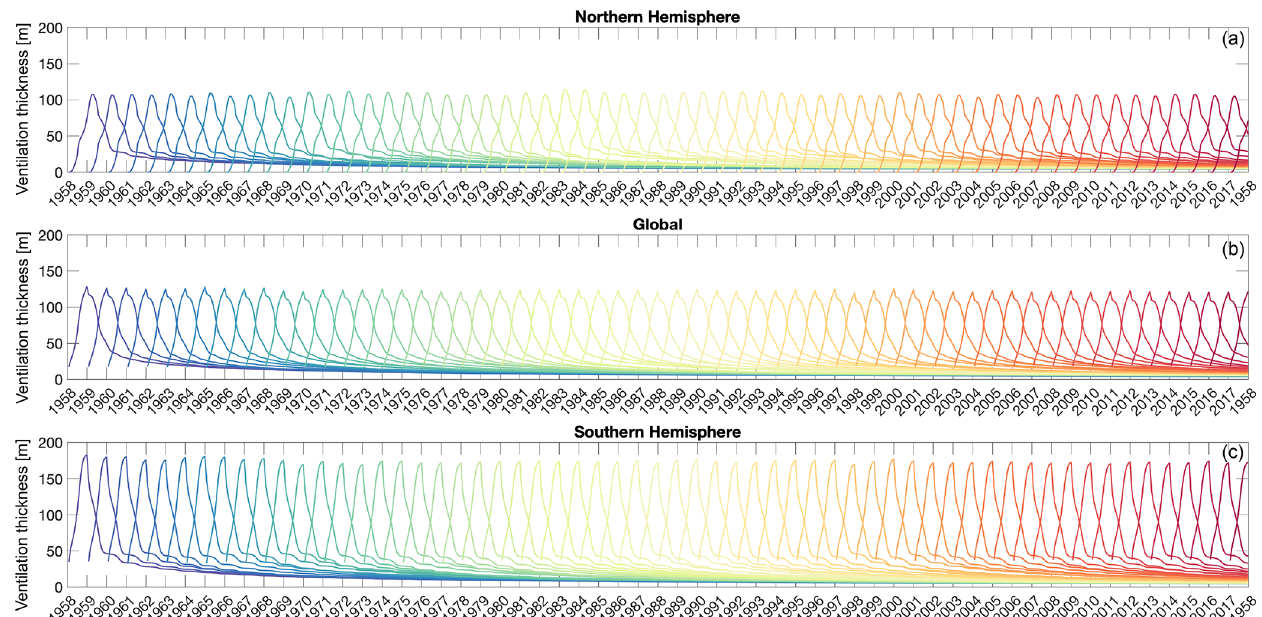
Figure 6. Ventilation thickness for all dyes/vintages (1958–2017) in the Northern Hemisphere (a) , as a global average (b) , and in the Southern Hemisphere (c)